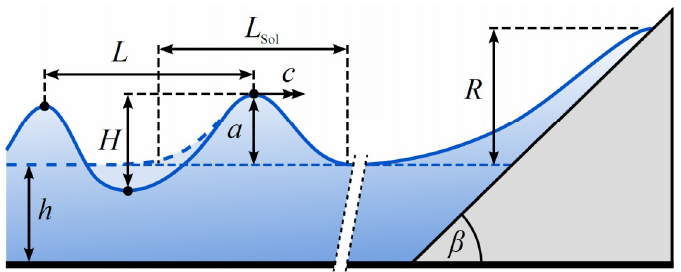
Figure 1. Definition plot for impulse (solid line) and solitary wave (dashed line) runup on an inclined slope.